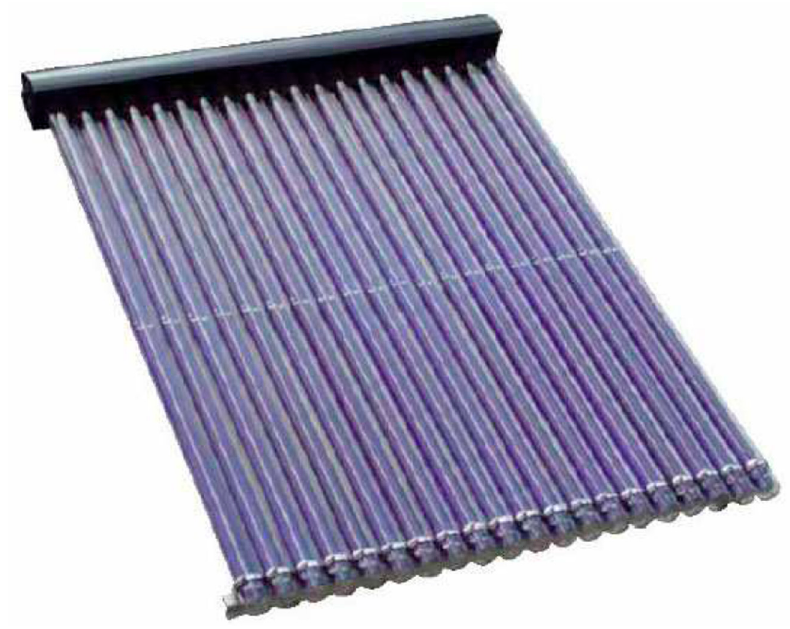
Figure 4. Vacuum-tube solar collector. The gross area of the solar collector is 4.3 m 2 , and the absorber area is 3 m 2 . The total weight of the unfilled collector is 87 kg. The device consists of an insulated manifold that removes heat from the heat pipe condensers. In the manifold, 20 vacuum tubes (Figure 5), 65 mm in diameter and 1765 mm long, are installed in